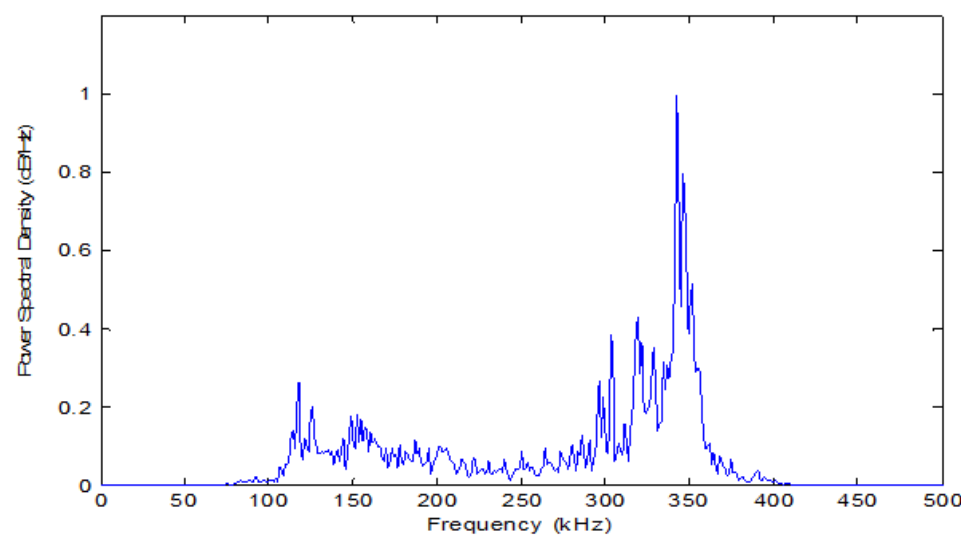
Figure 5. Raw acoustic emission (AE) signal at deflection of 3.22 mm.